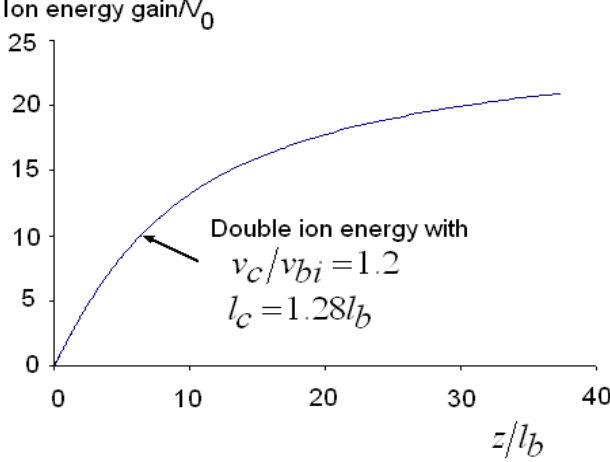
FIG. 11. (Color) Maximum ion energy gain in an untapered line vs system length normalized to l normalized to V 0 10 V 0